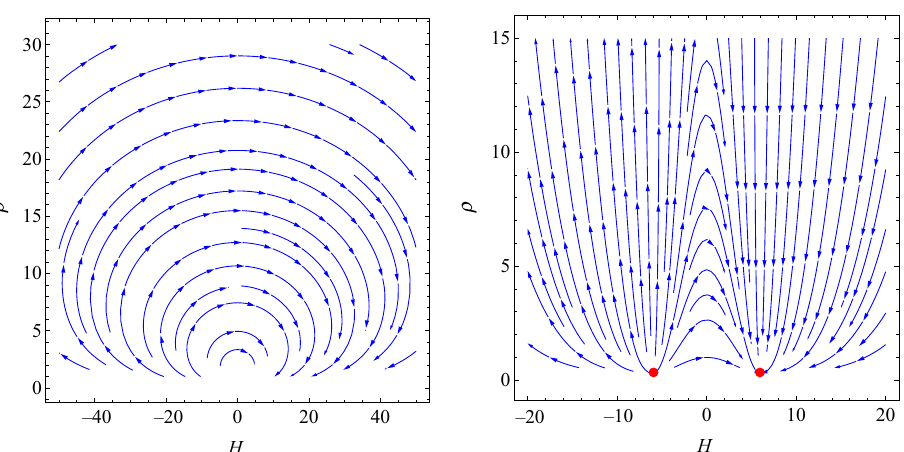
Fig. 4 The vector field portrait in phase space ( H ,ρ) corresponding to Fig. 3. Left panel corresponds to closed curvature mode of Snyder deformed-FRW model in the presence of maximum momentum with